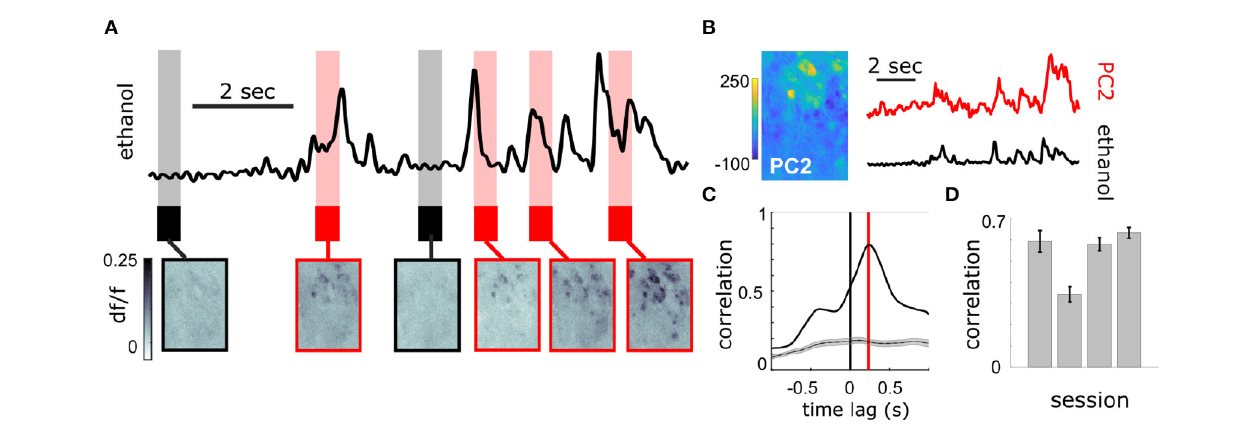
FIGURE 3 | Population response of MT cells in dorsal OB respond to changes in odor concentration during plume presentations. (A) Simultaneously recorded deconvolved ethanol plume (top) and imaging of calcium signals from MT cell activity in an example FOV of a Thy1-GCaMP6f (GP5.11) mouse (bottom). Baseline and odorless periods (black) and odor plume input (red) are shown from the indicated time points. Fluctuations in the odor plume elicit repeatable activation of specific glomerular networks in response to whiffs of odor during plume presentations. (B) (Left) An image of the principal component loadings corresponding to the odor-evoked activity [principal component 2 (PC2)]. (Right) Time series of PC2 (top, red) aligned to the simultaneous ethanol signal (bottom, black). Scale bar indicates 2 s. (C) Cross-correlogram between the two signals in (B) . Red line indicates a slight offset from 0 for the peak correlation ( ∼ 250 ms mean lag across FOVs from sensor to OB response). Gray plots average the null correlation ± SEM (correlation of neural activity from the example trial with odor signal from all non-matched trials in session). (D) Cross-correlations (mean ± SEM) between odor evoked population activity (principal component) and ethanol sensor signal are strong across 3 Thy1-GCaMP6f (GP5.11) mice ( r = 0.54 ±